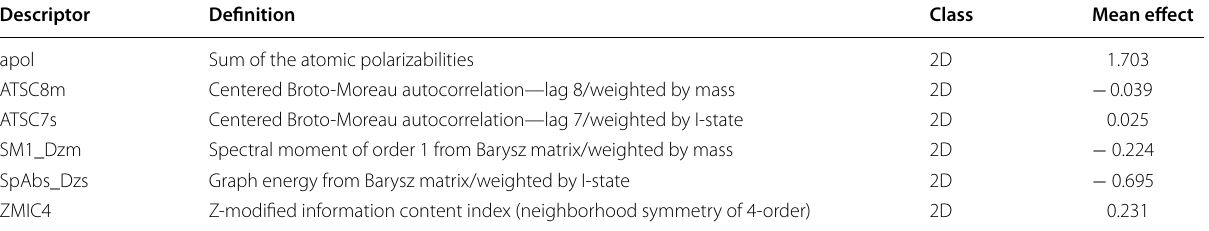
Table 5 Mean effect values of the most relevant descriptors